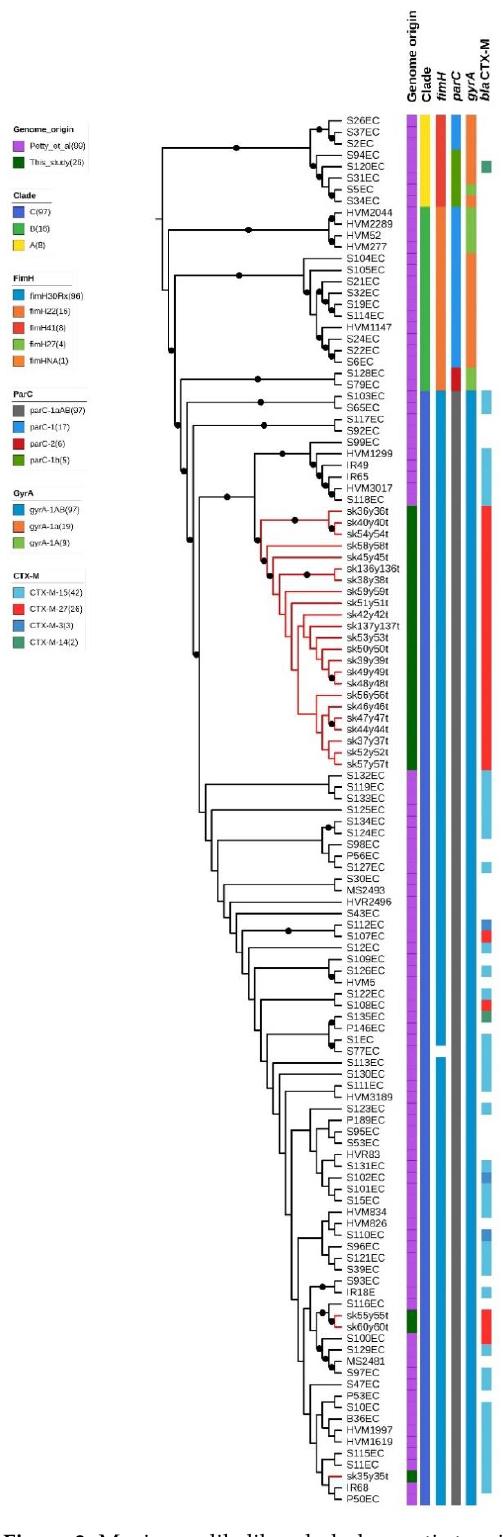
Figure 3. Maximum likelihood phylogenetic tree including the here studied ST131 strains and the ones from Petty et al. [20]. The branches corresponding to the strains of this study are highlighted in red. Metadata have been represented as follows: the first column indicates the origin of the strains; the second one the ST131 clades as called by Petty et al. [20]. The subsequent four columns report the allele variants of the fimH, parC, gyrA and bla CTX-M genes.